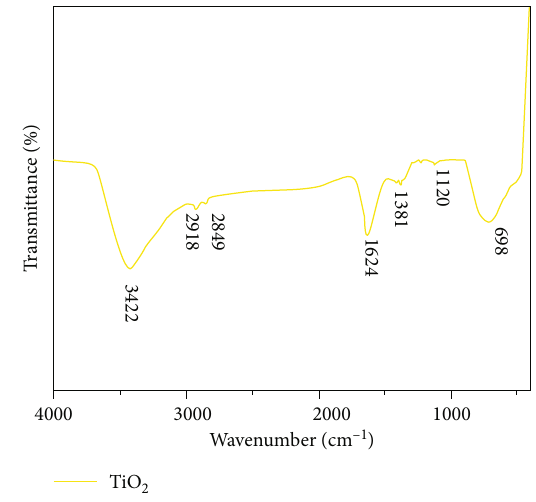
Figure 9: Synthesized TiO